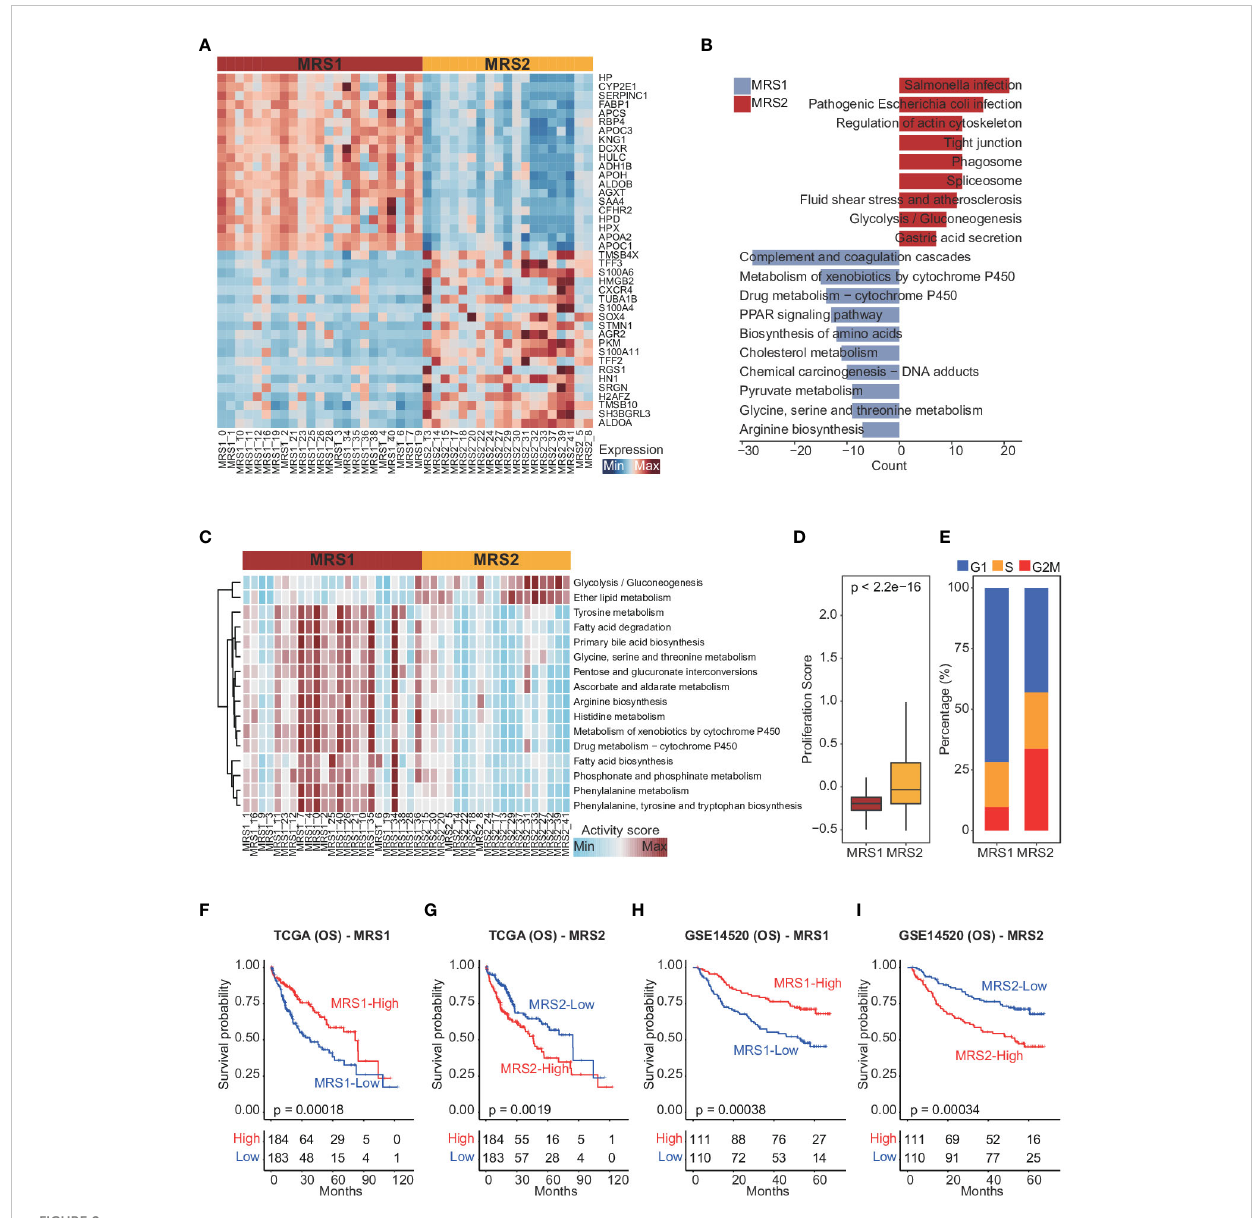
FIGURE 2 Dissection of metabolic epithelial cell subpopulations from HCC patients (A) Heatmap showing the top 20 subpopulation-speci fi c genes identi fi ed by the FindAllMarkers function. (B) Functional enrichment analysis of subpopulation-speci fi c genes. (C) Heatmap of metabolic pathways speci fi cally activated in MRS1 and MRS2. (D) Boxplot showing the proliferation scores of MRS1 and MRS2. Wilcoxon rank-sum test was used to measure the differences between two groups. Horizontal lines in the boxplots represent the median, the lower and upper hinges correspond to the fi rst and third quartiles, and the whiskers extend from the hinge up to 1.5 times the interquartile range from the hinge. (E) Fraction of cells in the G1 (blue), S (orange) and G2M (red) phases in MRS1 and MRS2. (F-I) Kaplan-Meier curves showing the overall survival (OS) of HCC patients in